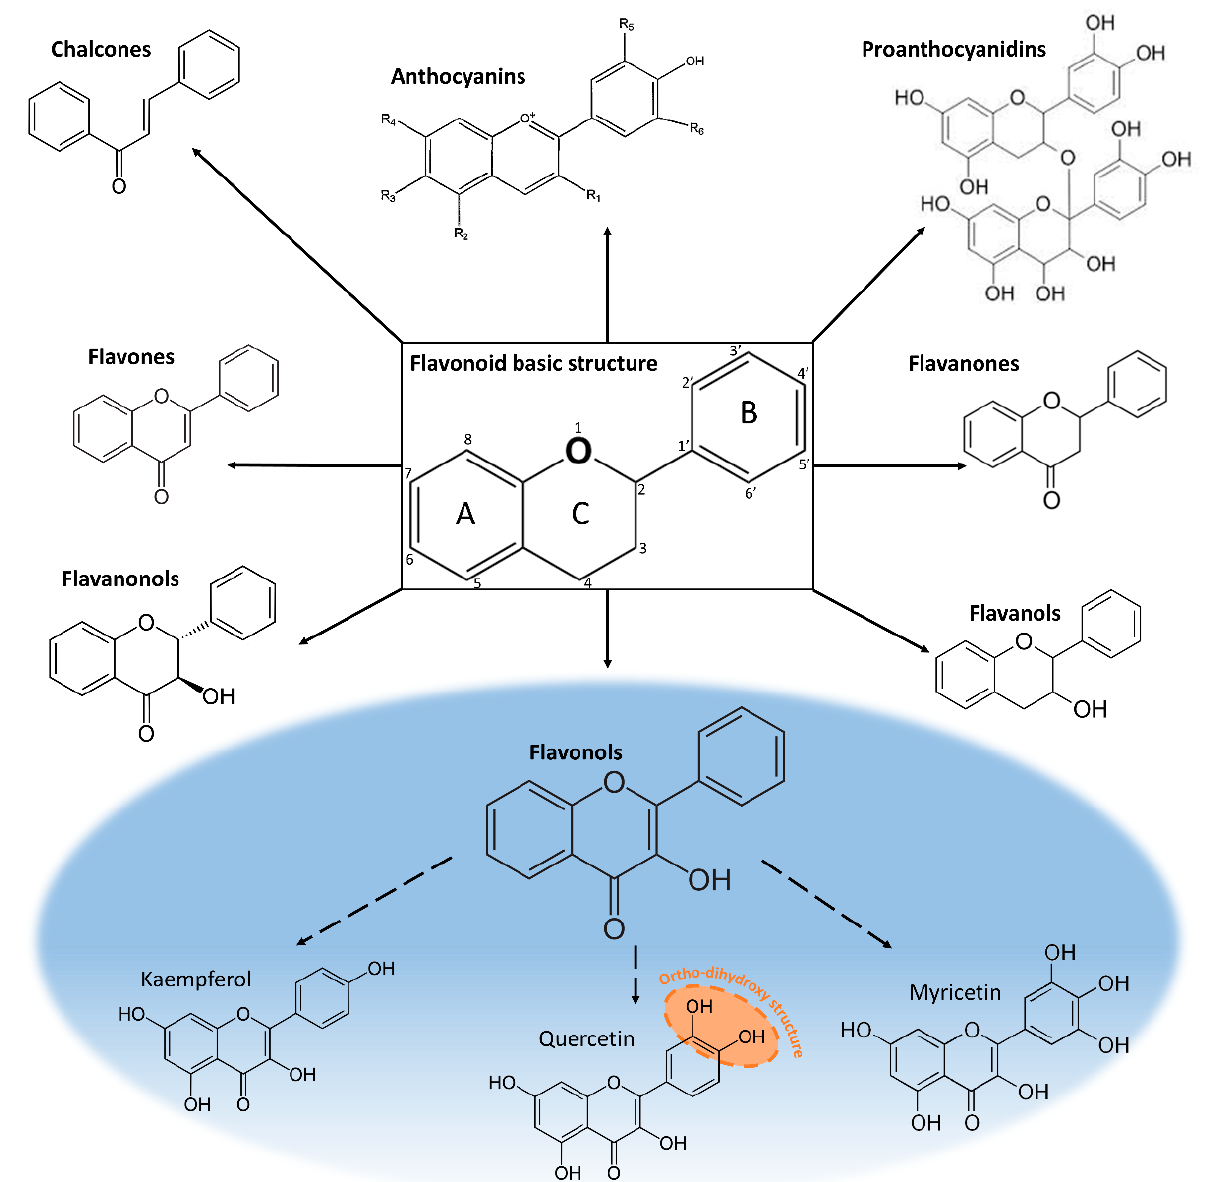
Figure 1. Structure and classification of flavonoids. The main subclasses of major flavonols are circled in blue. The difference between flavonoid groups depends on the chemical structure, the degree of oxidation, and the unsaturation of the linking chain (C3). Flavonols differ from each other in the number and position of the hydroxyl groups (-OH). The ortho- dihydroxy structure of quercetin is circled in orange.